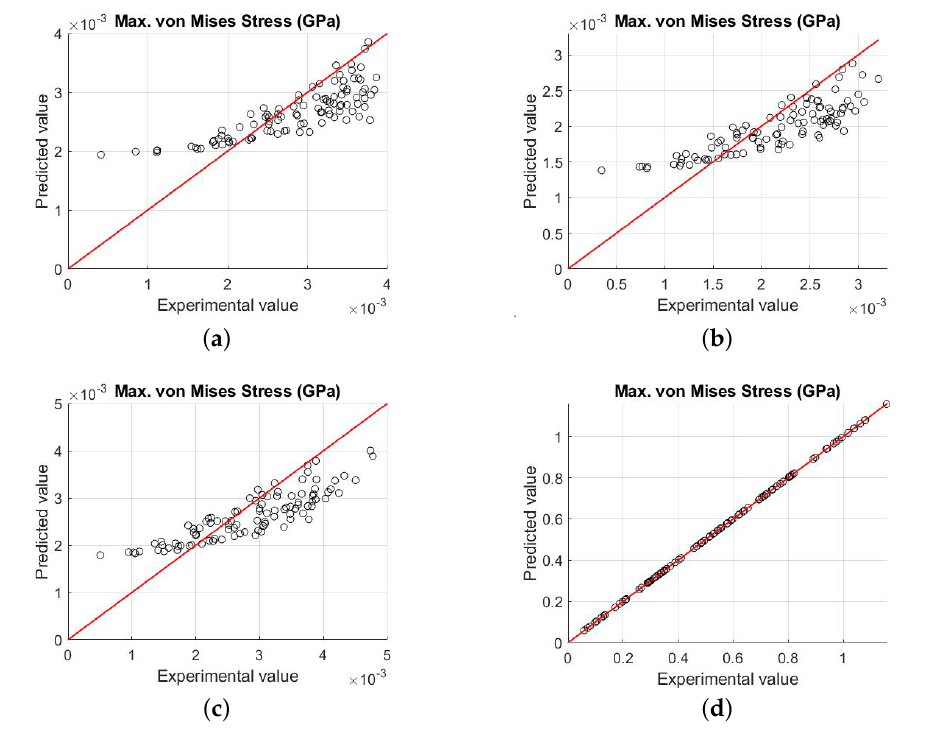
Figure 4. Experimental (result of lattice FEA) vs. predicted (result of the meta-model) von Mises stress in Schwarz primitive lattices of relative density ( a ) ρ = 0.25; ( b ) ρ = 0.50; ( c ) ρ = 0.75; and ( d ) ρ =